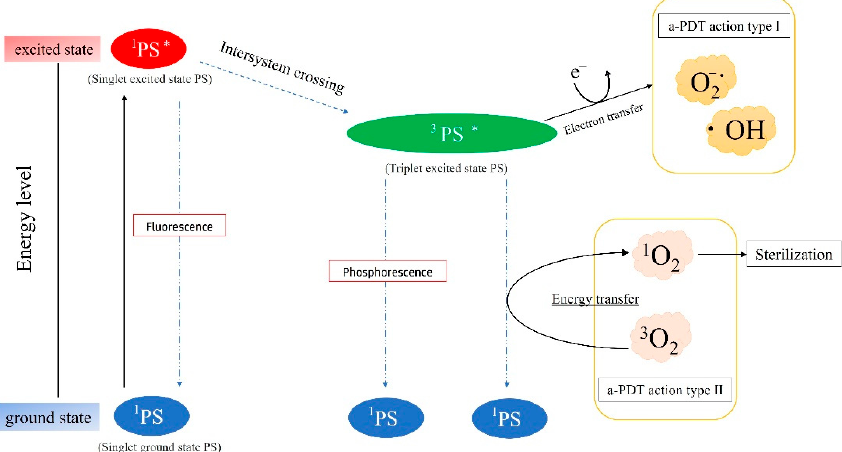
Figure 3. ROS and the mechanisms of photodynamic therapy (PDT; types 1 and 2). Singlet ground state photosensitizer ( 1 PS) is irradiated with excitation light and changes to singlet excited state PS ( 1 PS*). Subsequently, 1 PS* changes to the triplet excited state PS ( 3 PS*) or 1 PS via fluorescence, luminescence, and intersystem crossing. The type 1 and 2 reactions occur by electron transfer to 3 PS*, and by energy transition when 3 PS* changes to 1 PS, respectively.